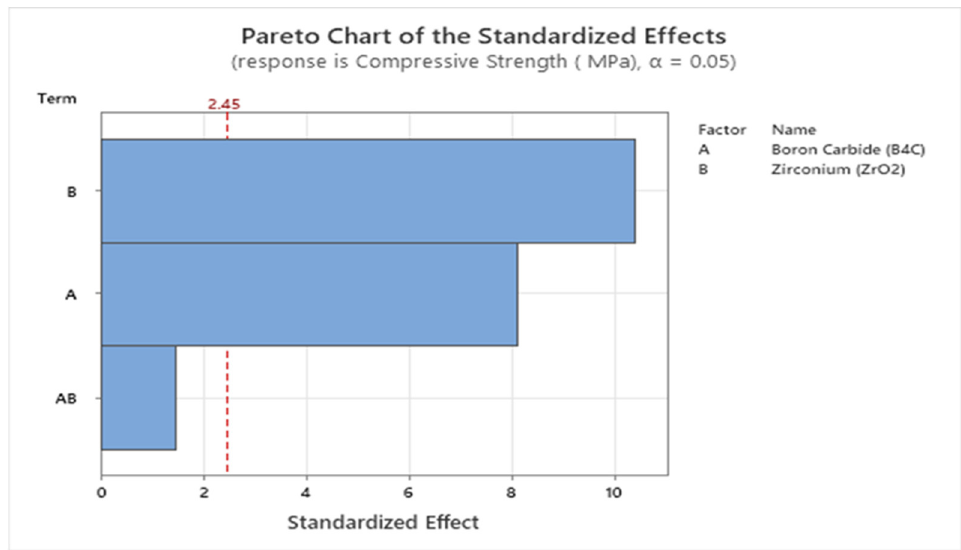
Figure 2. Pareto chart of compressive strength.